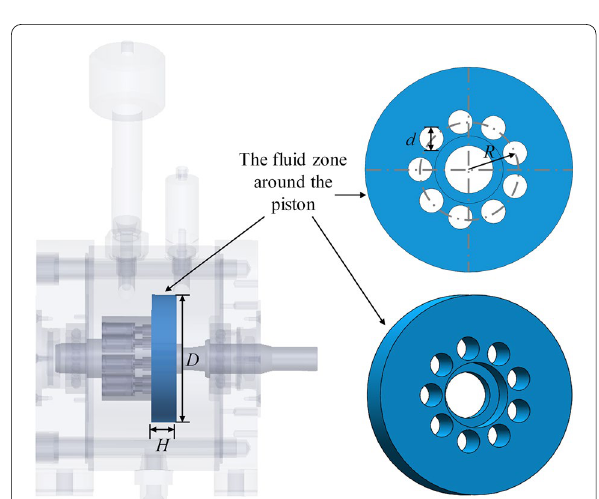
Figure 2 Fluid zone around the piston in the churning losses test